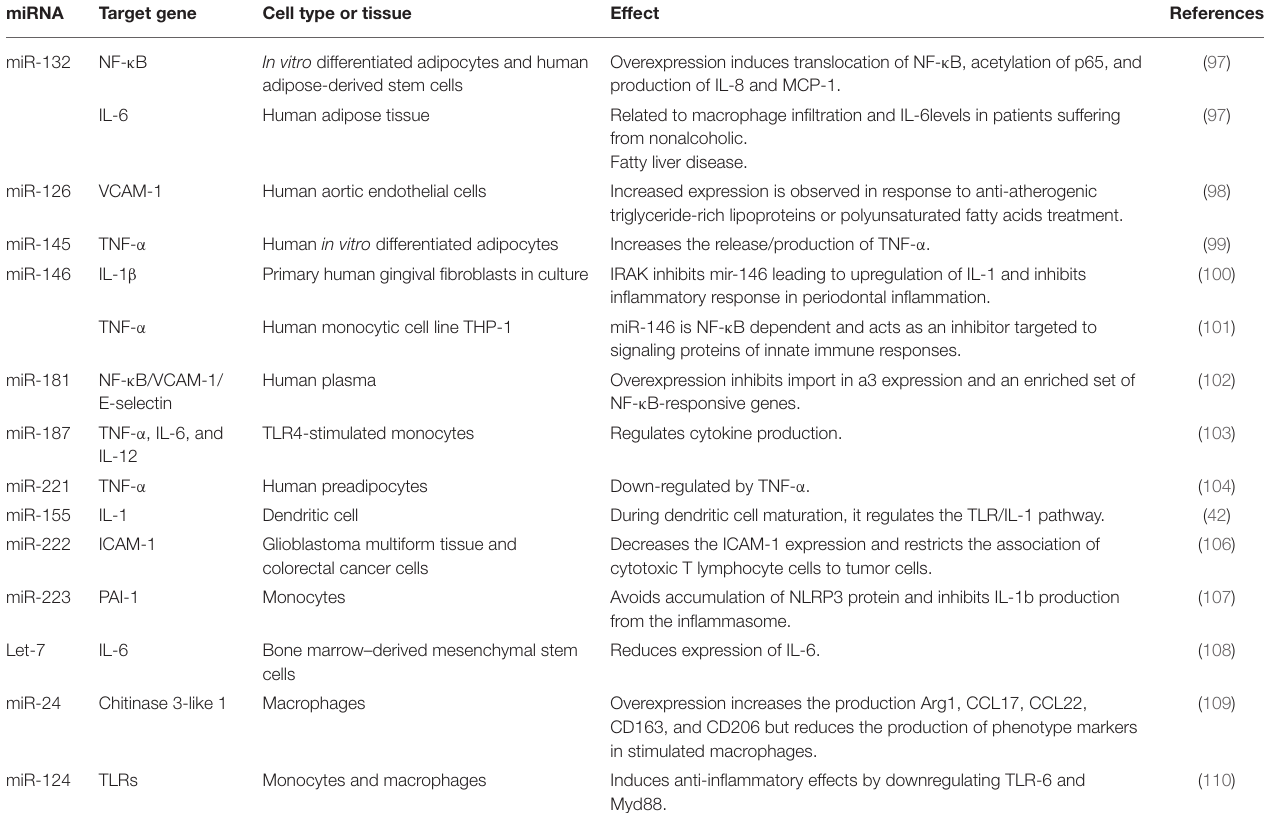
TABLE 2 | Role of miRNAs in the inflammatory process and their target genes.